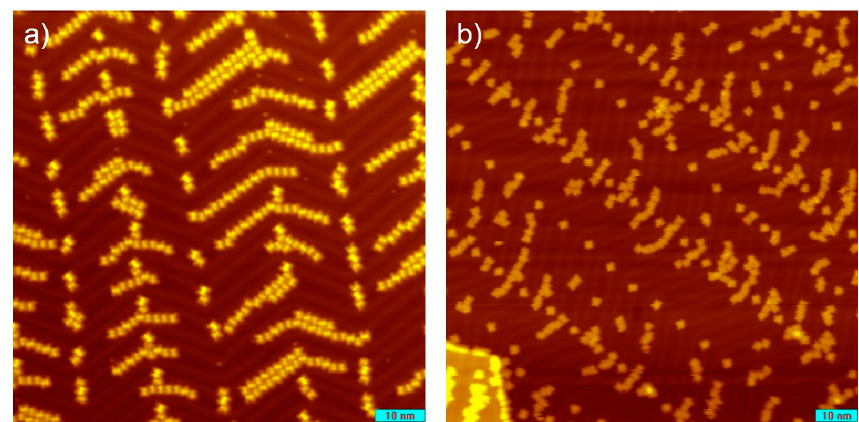
Figure A3. Large-scale STM images of Co(TAP) adsorbed Au(111) surface annealed ( a ) at room temperature, and ( b ) at 750 K. The blue scale bars in ( a ) and ( b ) represent 10 nm. Imaging conditions: ( a ) − 1.0 V, 30 pA; ( b ) 2.5 V, 60 pA.